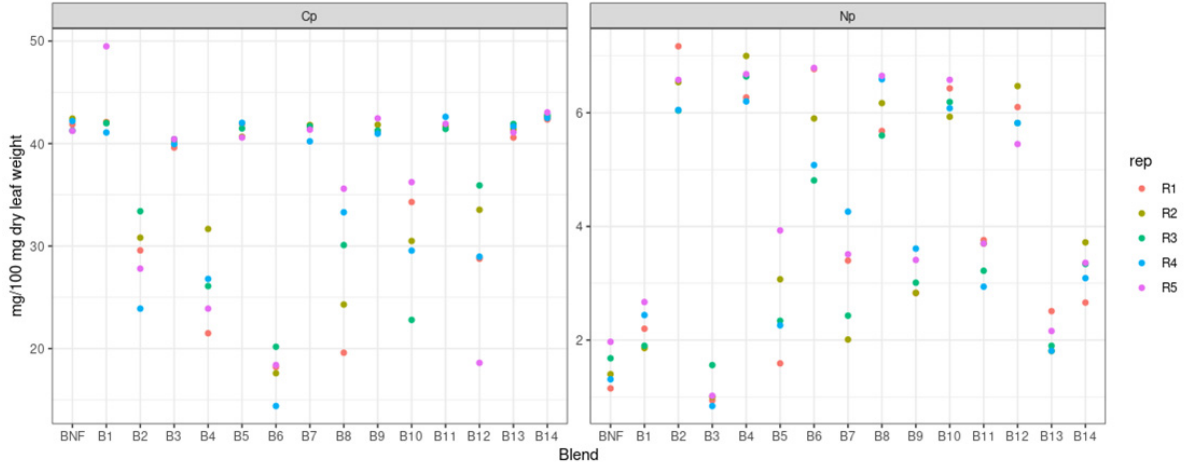
Figure 5. Carbon (Cp) and Nitrogen (Np) concentration in the plant tissues (mg 100 mg − 1 dry matter) for all the tested blends showing all the replicates (n = 5).